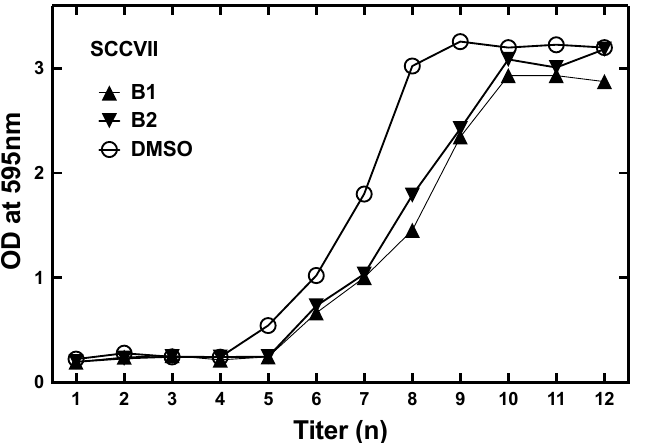
Figure 5. Cell toxicity, IC 50 (moles/liter), i.e., the concentration at which it inhibited the growth of SCC VII cells by 50% after 3 day of continuous exposure, was determined via CellTiter 96 ® Aqueous One Solution Cell Proliferation Assay.